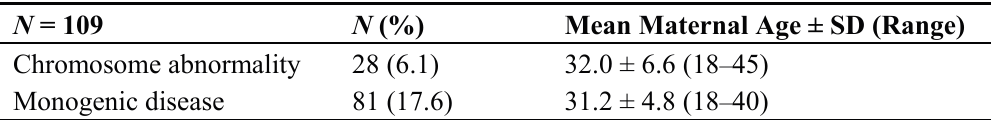
Table 1. Number of affected cases among the 460 chorionic villus sampling